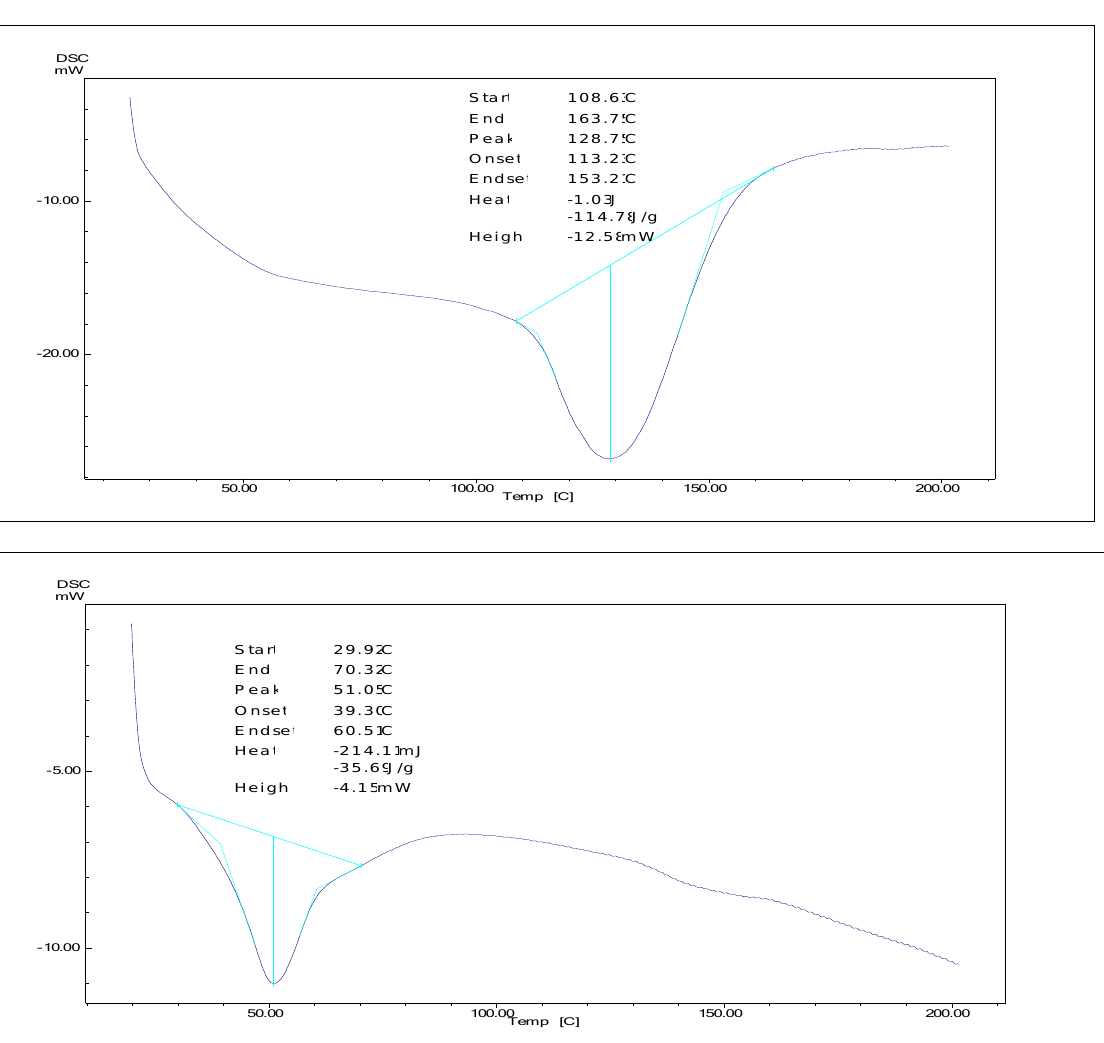
Figure 5. SEM micrograph for pure AC powder at 36.23 KX magnification (A) , lyophilized F11 at 78.00 KX magnification (B) and lyophilized F15 at 78.00 KX magnification (C).